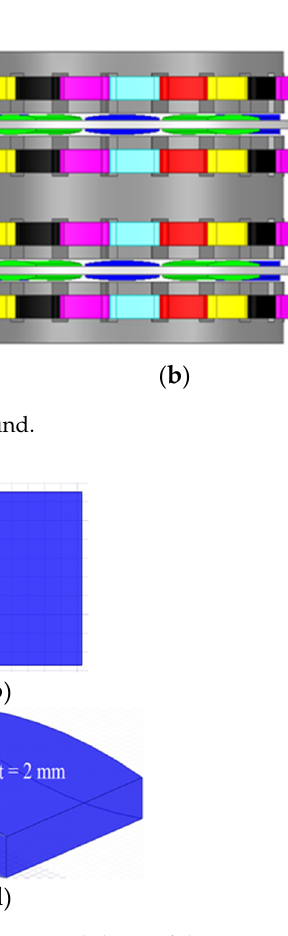
Figure 5. Modification of permanent magnet pole. ( a , c ) original shape of the permanent magnet pole, ( b , d ) modified shape of the permanent magnet pole.